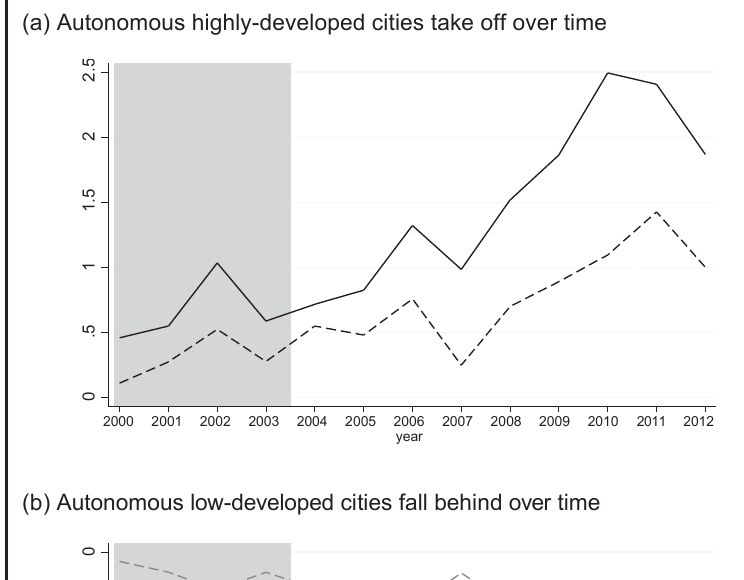
Evolution of test scores for the two groups of cities over time. (a) Autonomous highly developed cities take off over time. (b) Autonomous low-developed cities fall behind over time. (c) Autonomy widens the inequality fork over time. Notes: The figure shows the test score deviations from the national average. Autonomous cities are solid, and nonautonomous ones are dashed. Highly developed cities are in darker color, low-developed ones are in lighter color. Pre-reform and transition years are shaded in